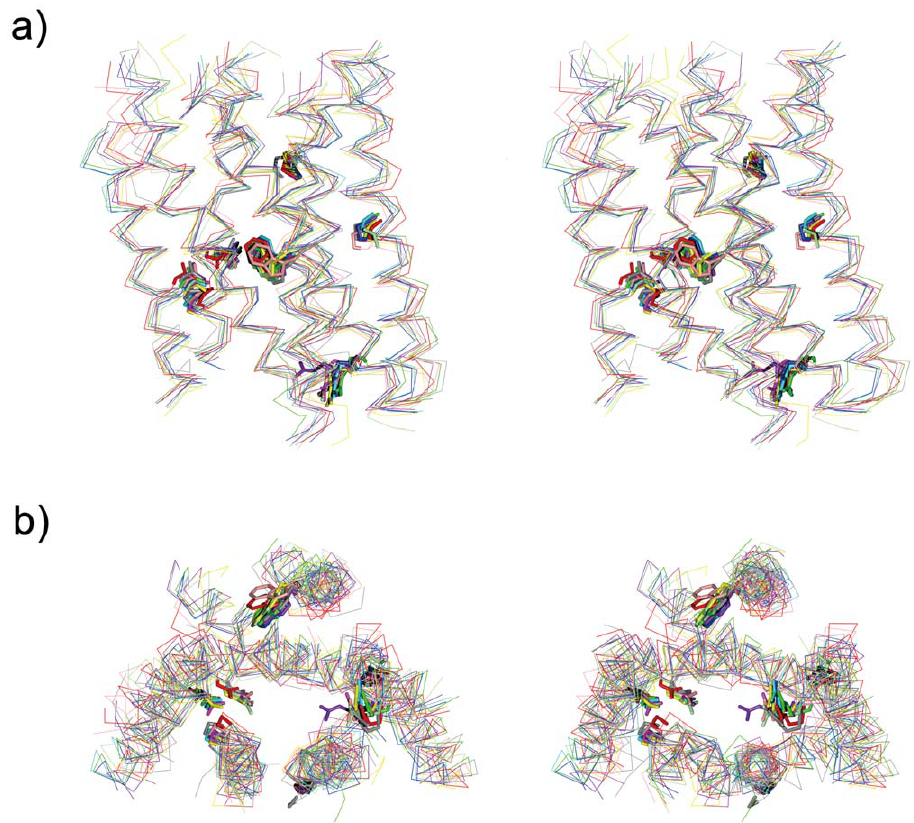
Figure 1. Stereo view of molecular overlay of 10 representative 7TM bundles of inactivated GPCRs of known structure. a) The extracellular side is facing upward while helix I is shown on the left. b) The 7TM bundles are viewed from the bottom of a). Seven highly conserved residues (*.50 s) are shown on the C a backbone traces. The colors of receptors are red, bovine rhodopsin (1U19-A); pink, squid rhodopsin (2Z73-A); blue, b 2 receptor (2RH1); cyan, b 1 receptor (2VT4-B); yellow, A2A receptor (3EML); gray, CXCR4 receptor (3ODU-A); magenta, D3 receptor (3PBL-A); purple, H1 receptor (3RZE); green, M2 receptor (3UON); light green, S1P1 receptor (3V2Y).